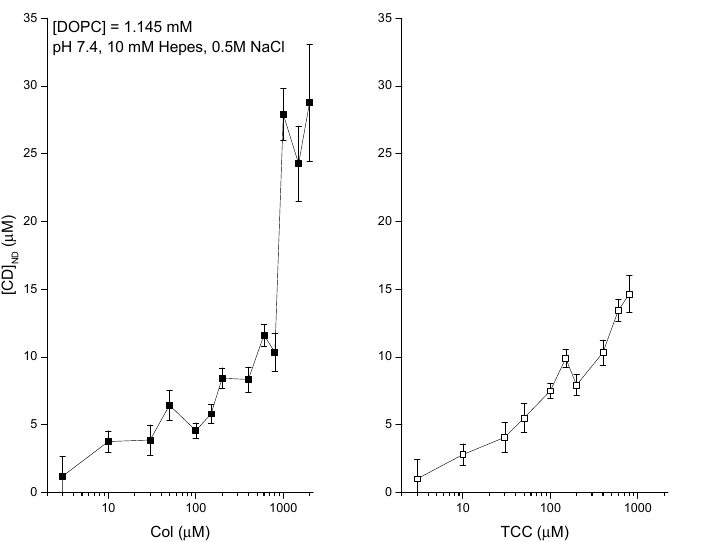
Figure 6. Two sets of data have been presented quantifying the direct detection method (DDM) detected liposome-bound colchicine for various aqueous environments bathing the liposome. Left panel: liposome-bound colchicine as a function of various Col concentrations in aqueous phase. Here, I tested up to reaching at the equilibrium condition on liposome adsorption of drugs. Right panel: liposome-bound TCC as a function of various TCC concentrations in aqueous phase. Here, I tested at low TCC concentrations and avoided reaching the equilibrium condition because of the insufficient amount of colchicine derivative TCC that could have been saved from our previous stock used in studies [1,2]. Concentration of lipids in the cuvette/buffer has been maintained for all investigations at [dioleoylphosphatidylcholine (DOPC)] = 1.145 mM.